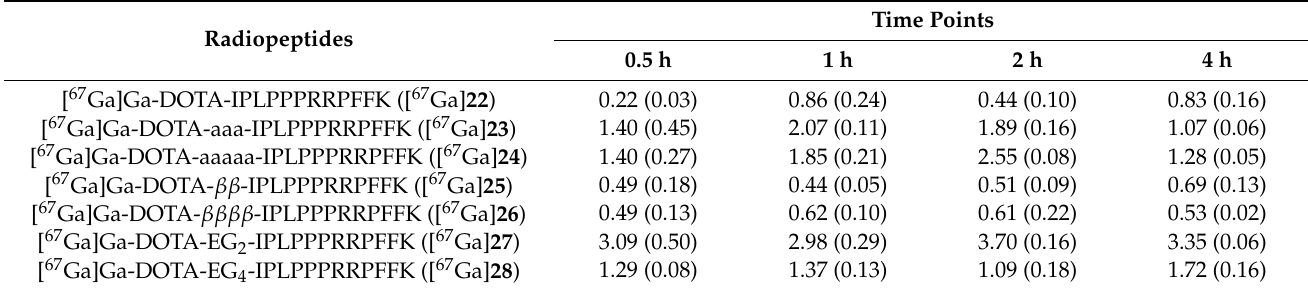
Expressed as % dose/mg protein. Data were presented as the mean (SD) for four samples.